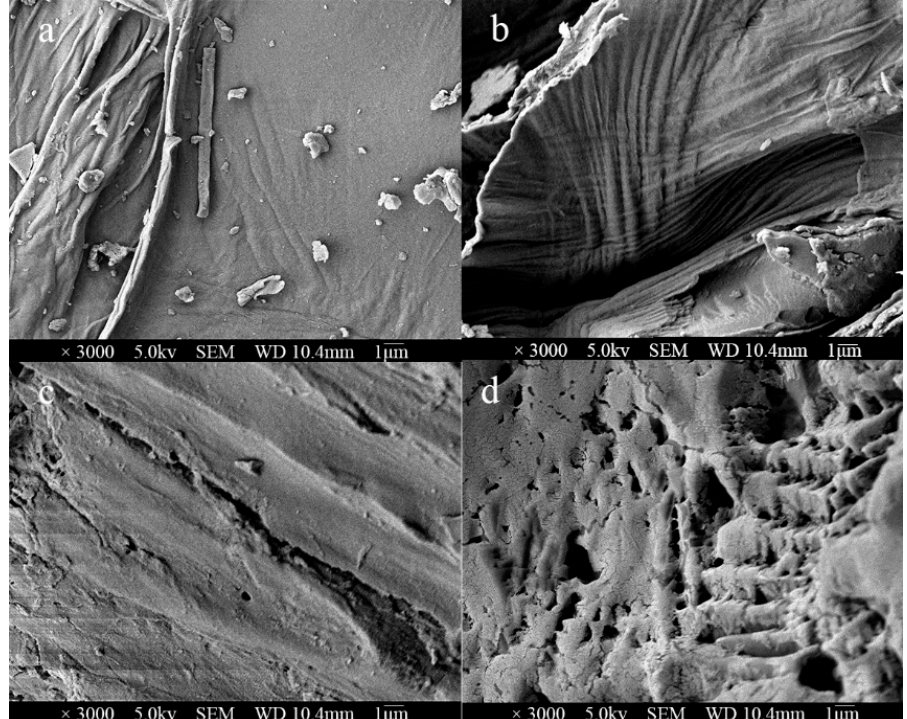
Figure 2. The field emission scanning electron microscope images of X. sorbifolia powder: ( a ) X. sorbifolia crude drug powder; ( b ) X. sorbifolia powder extracted by water; ( c ) X. sorbifolia powder extracted by ethanol; ( d ) X. sorbifolia powder extracted by TPMBr-La.